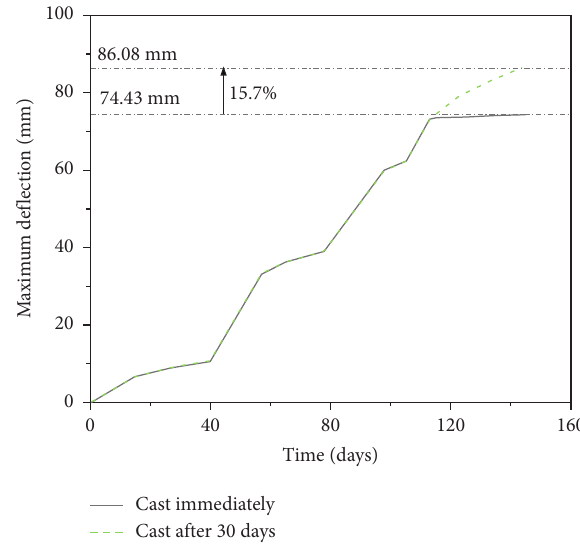
Figure 9: Comparison of maximum deflections between cases of the cast immediately and cast after 30 days from completing ex- cavation, modified from [44].